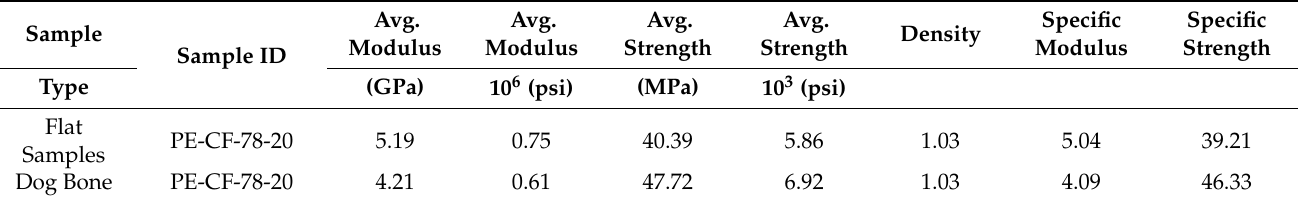
Table 5. Tensile modulus and strength—C/PE (preform